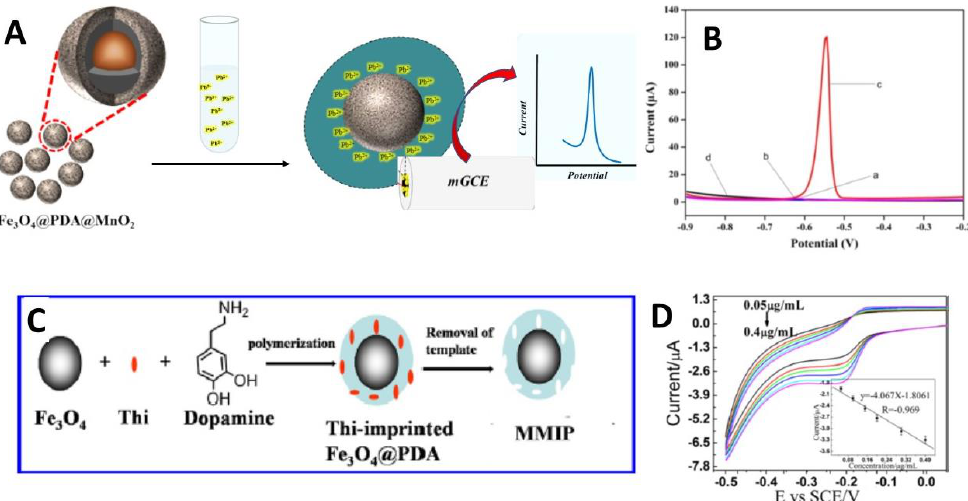
Figure 5. ( A ) Capture and detection of the target Pb(II) in sample solution; ( B ) Differential pulse voltammograms of the developed nanocomposites (reproduced with permission from ref. [101]); ( C ) Schematic illustration of the fabrication process of Fe 3 O 4 NPs MMIPs; ( D ) Cyclic voltammetry from Fe 3 O 4 NPs MMIPs-modified glassy carbon electrode (GCE) dose dependent (reproduced with permission from ref. [102]). Copyright 2017